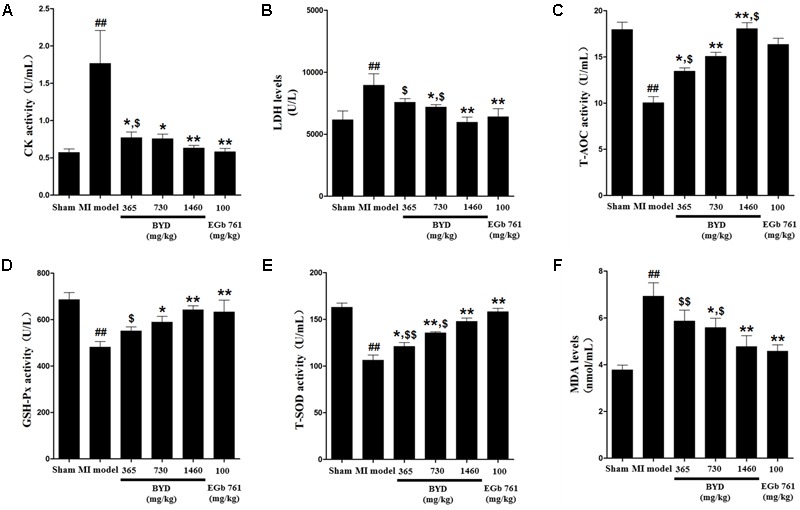
Effects of BYD on serum biochemical indicators in MI rats. (A) CK; (B) LDH; (C) T-AOC; (D) GSH-Px; (E) T-SOD; (F) MDA. Values expressed as the mean ± SD. Significance was assessed with a two-tailed Student’s t-test: ##p < 0.01 vs. the sham group; ∗p < 0.05 or ∗∗p < 0.01 vs. the MI group; $p < 0.05 or $$p < 0.01 vs. the positive control group.